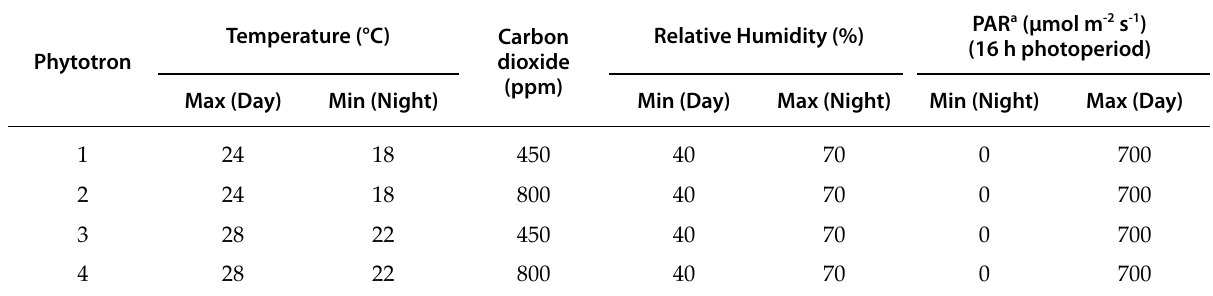
Table 1. Different environmental conditions used in phytotrons for assessing the effects of elevated CO on interactions of zucchini and powdery